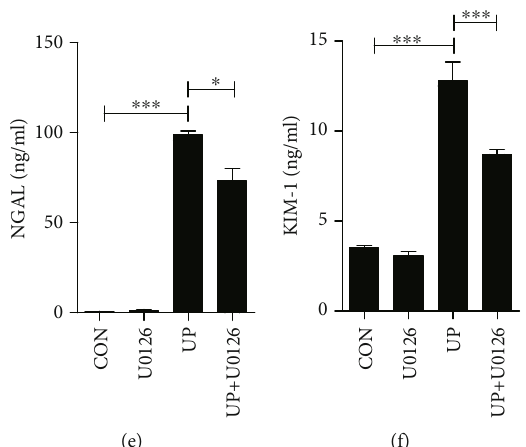
Figure 2: E ff ect of MEK inhibitor on urinary protein-induced injury. MEK inhibitor U0126 (10 μ M) was administered 1 h before the addition of 8 g/l urinary proteins. The aliquots of cell lysate were subjected to Western blot analysis of p-ERK and t-ERK levels (a, b), and cellular apoptosis was assessed by Annexin V-FITC/PI fl ow cytometry analysis (c, d) at 48 h. Cell culture supernatant was subjected to ELISA analysis of the NGAL and KIM-1 secretion at 12h (e, f). (b) F ð 38 Þ = 13 : 385 ; (d) F ð 3 8 Þ = 8 : 539 ; (e) F ð 3 12 Þ = 207 : 111 ; (f) F ð 316 Þ = 72 : 157 . ∗ P < 0 : 05 , ∗∗ P < 0 : 01 , and ∗∗∗ P < 0 : 001 . CON: control; UP: urinary proteins.